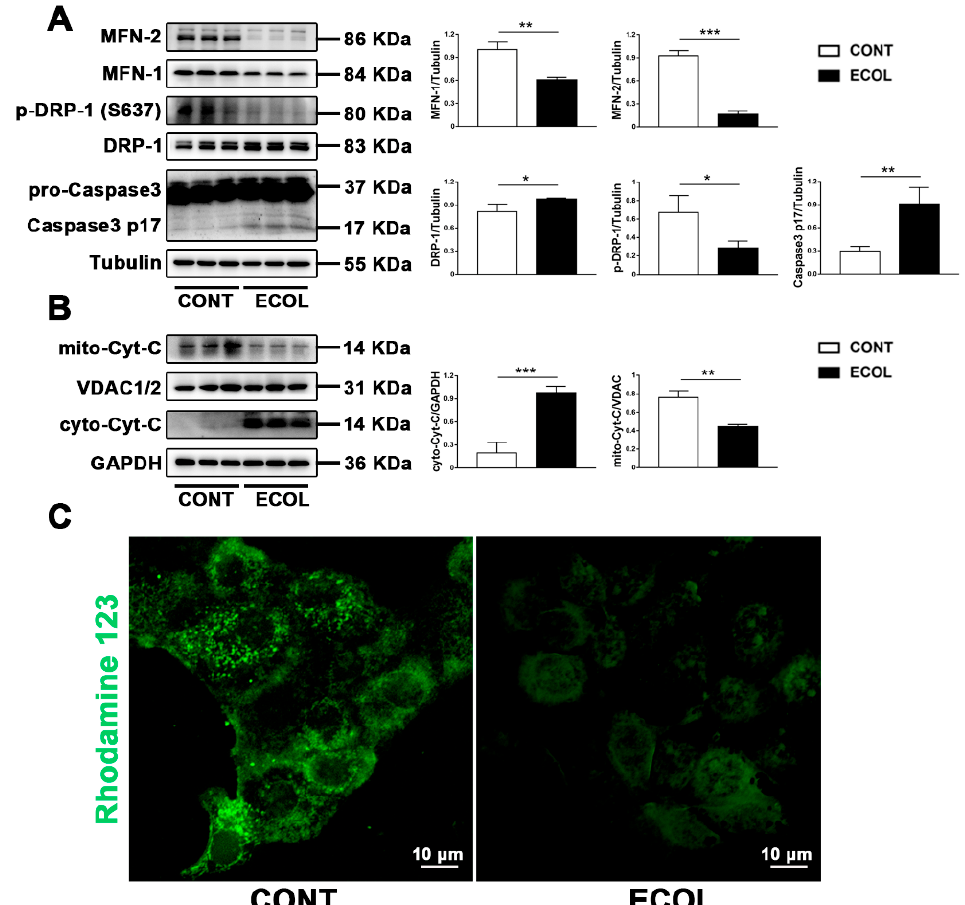
Figure 1. E. coli (EPEC) increases mitochondrial fission, decreases fusion, induces Cyt-C release and decreased MMP, and eventually leads to apoptosis. ( A ) The DRP-1, p-DRP-1 (ser637), MFN-1, and MFN-2 levels were analyzed by Western blot. ( B ) Cell mitochondria were isolated to analyze the Cyt-C level in mitochondria and cytoplasm by Western blot. ( C ) Rhodamine123 staining was used to observe the MMP changes. Scale bar, 10 µm. Representative images are shown. MAC-T cells were washed with PBS and challenged with E. coli (EPEC) for 8 h (MOI = 66). Data are from 3 independent experiments and presented as the mean ± SEM; * p < 0.05, ** p < 0.01, *** p < 0.001.